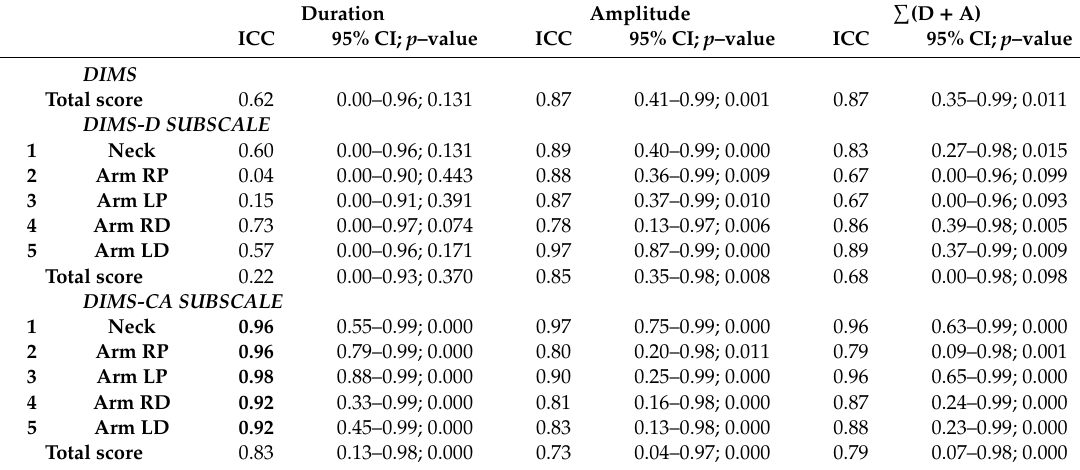
Table 2. Interrater reliability: Intraclass correlation coe ffi cients (ICC) with 95% confidence intervals (CI) between three raters for the Dyskinesia Impairment Mobility Scale